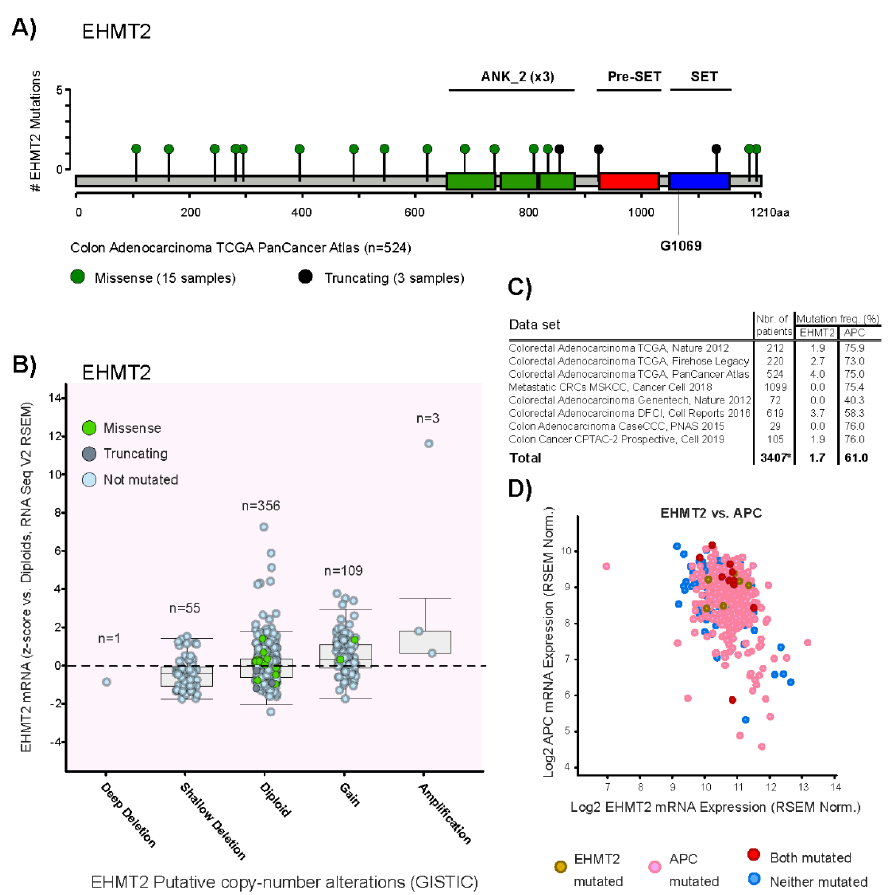
Figure 1. Mutational status of EHMT2/G9a and its relationship with mRNA expression in human colorectal tumors. ( A ) Domain architecture of the EHMT2 gene and mutations reported in Colorectal Adenocarcinoma TCGA PanCancer Atlas dataset, including 524 cases. ( B ) Distribution of EHMT2 genomic aberrations and mutations vs. mRNA expression (z-scores vs. diploid samples, RNA Seq V2 RSEM) in human colorectal tumors ( n = 524 cases). ( C ) EHMT2 and APC mutation frequency from